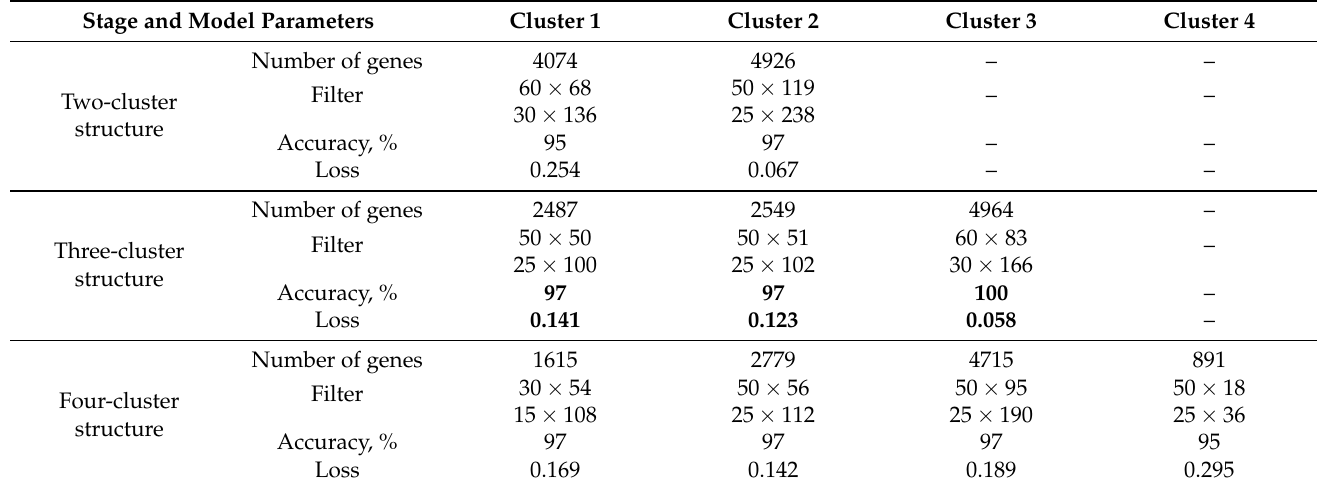
Table 4. Simulation results regarding the step-by-step application of the hybrid inductive model of GEP clustering based on the spectral clustering algorithm and